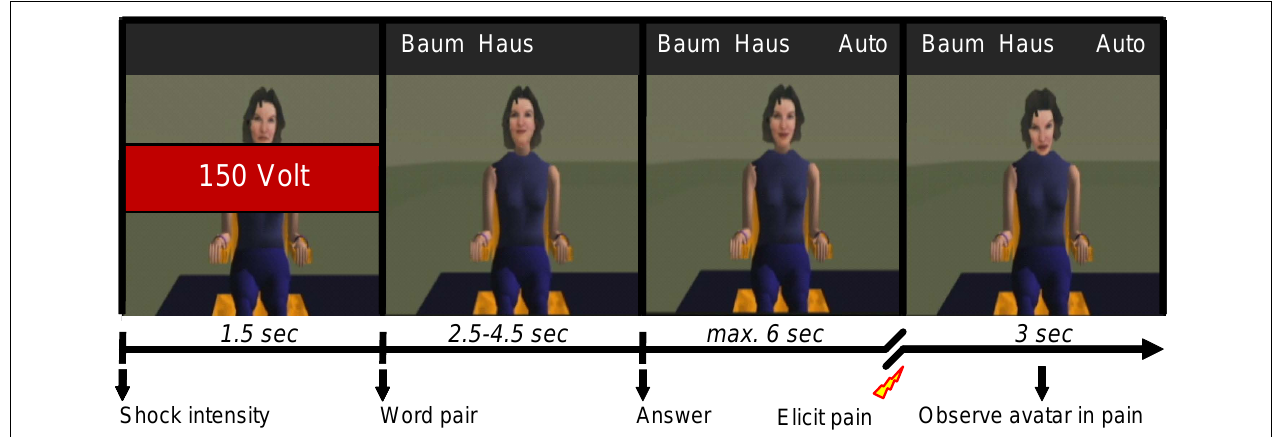
so results in a text box appearing on the screen for 1.5 s instructing that pain must be applied whenever the avatar makes a mistake. The critical condition for analysis in this study then follows as the participant observes for 3 s the avatar’s suffering. In the non-pain trails, the avatar is simply observed after giving her correct answer. Both trial types conclude with a task-unspecifi c blank screen with fi xation cross presented for 6–8 s, after which the next trail begins. The avatar is visible for the duration of every trial, the timing of events (all jittered) over the course of each trial being designed to generate as realistically as possible the sense of a true interaction between participant and